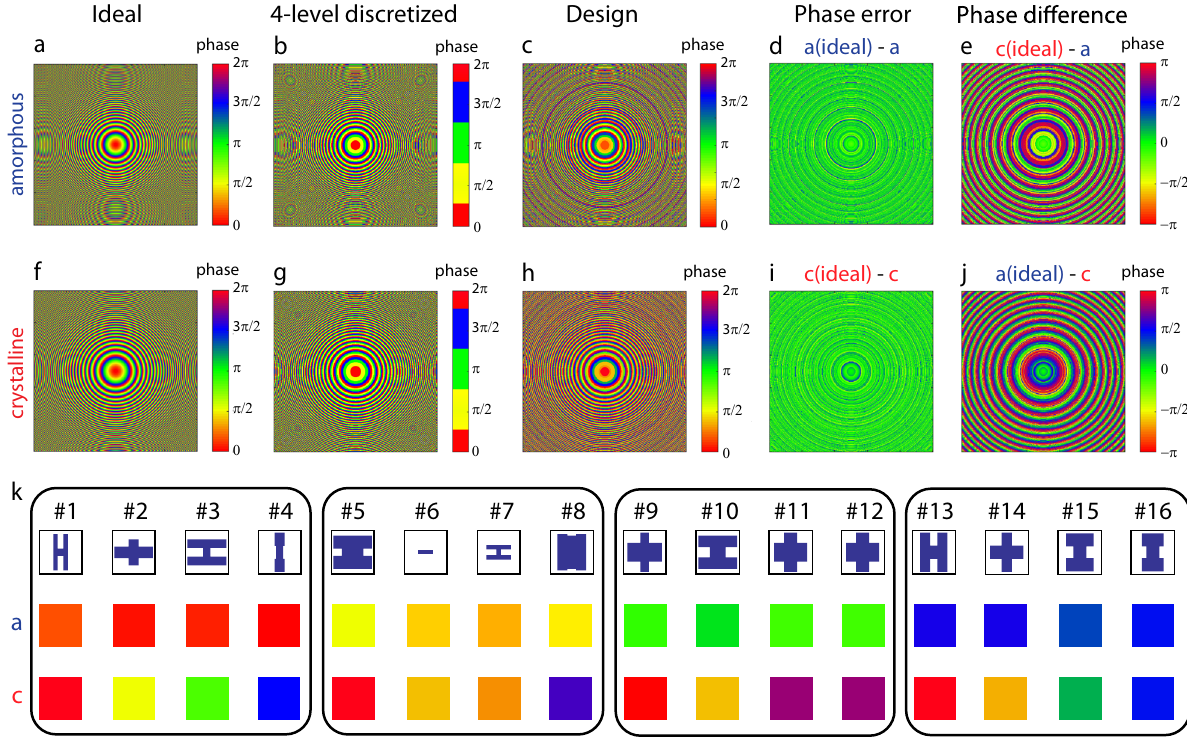
Fig. 2 Phase maps of the metalens in amorphous and crystalline states. a , f Ideal target phase pro fi les with continuous phase distribution; b , g four-level discretized phase pro fi les; and c , h fi nal design taking into account phase responses of the meta-atoms. Difference between the ideal and fi nal design phase maps at the d , i primary and e , j phantom focal planes. k 16 meta-atoms selected to construct the recon fi gurable metalens. Colors correspond to the phase values shown in c , h